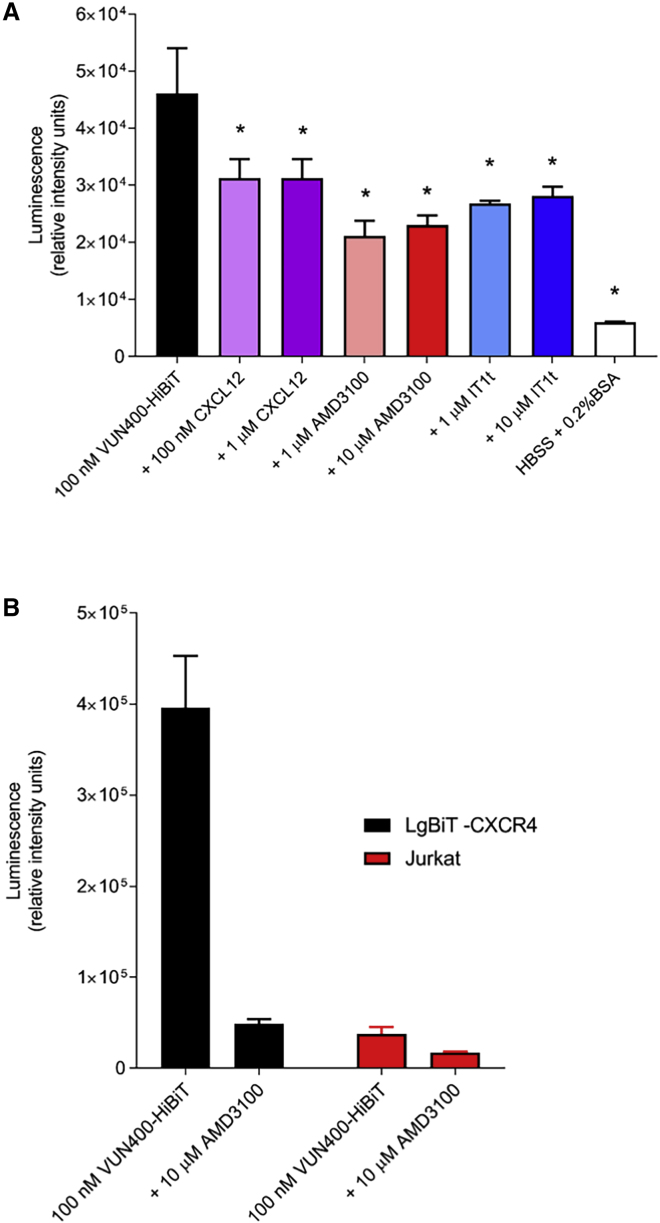
‘VUN400-HiBit Binding in Immortalized T cells(A) Complemented luminescence of Jurkat cells treated with 100 nM VUN400-HiBiT in the absence or presence of CXCL12, AMD3100, or IT1t, following the addition of 20 nM purified LgBiT. Also shown is the background luminescence due to the addition of HEPES-buffered saline solution + 0.2% bovine serum albumin in place of VUN400-HiBiT. Data are mean ± SEM from triplicate determinations in a single experiment. This single experiment is representative of six separate experiments. ∗p < 0.05, comparing ligand treatment with 100 nM VUN400-HiBiT treatment alone, one-way ANOVA with Dunnett's post hoc test for multiple comparisons in this single experiment. Analysis of the complete mean data obtained in all six repeat experiments were subjected to two-way ANOVA (experiments and treatments between the two variables) and yielded significant inhibitions (p < 0.05) by all ligand concentrations apart from 100 nM CXCL12.(B) VUN400-HiBiT to compare CXCR4 expression levels. Luminescence signal from LgBiT-CXCR4 or Jurkat cells treated with 100 nM VUN400-HiBiT in the absence and presence of 10 μM AMD3100. Complemented luminescence in Jurkat cells was achieved with the addition of 20 nM purified LgBiT. Data are mean ± SEM from triplicate determinations in a single experiment. This single experiment is representative of four separate experiments.